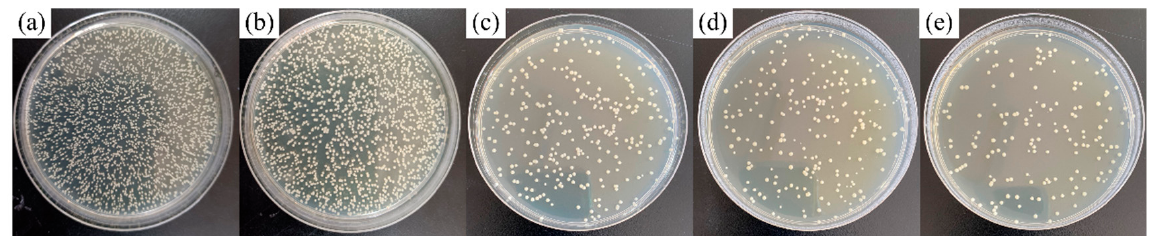
Figure 10. Typical photos of the re-cultivated S. aureus colonies on agar for different samples: ( a ) Substrate; ( b ) Ag-1 × 10 16 ions/cm 2 ; ( c ) Ag-5 × 10 16 ions/cm 2 ; ( d ) Ag-10 × 10 16 ions/cm 2 ; ( e ) Ag-15 × 10 16 ions/cm 2 .